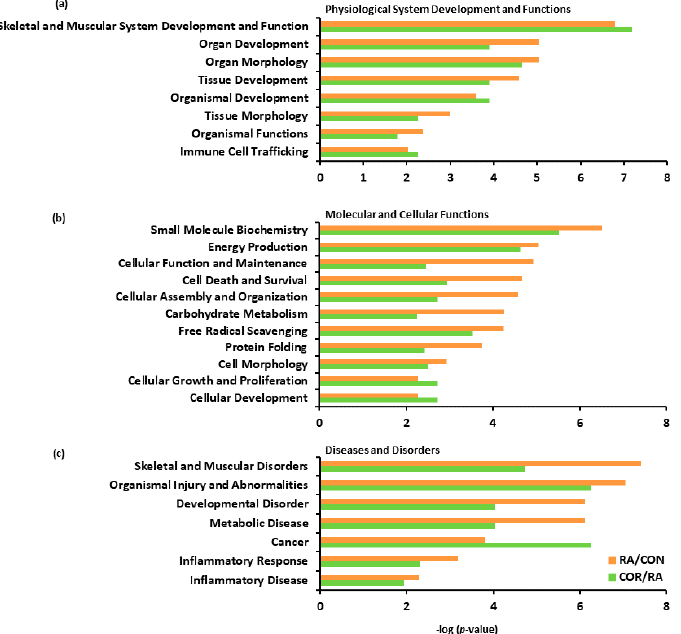
Figure 7. The most relevant biofunctions affected by RA and the effects of coriander treatment. Biofunctions were classified into three primary categories: ( a ) Physiological System Development and Functions, ( b ) Molecular and Cellular Functions, and ( c ) Diseases and Disorders. Biofunctions involved in the RA/CON comparison are presented in orange color, whereas the same biofunctions involved in the COR/RA comparison are presented in green color. -log ( p -value) > 1.3 represents p -value < 0.05.